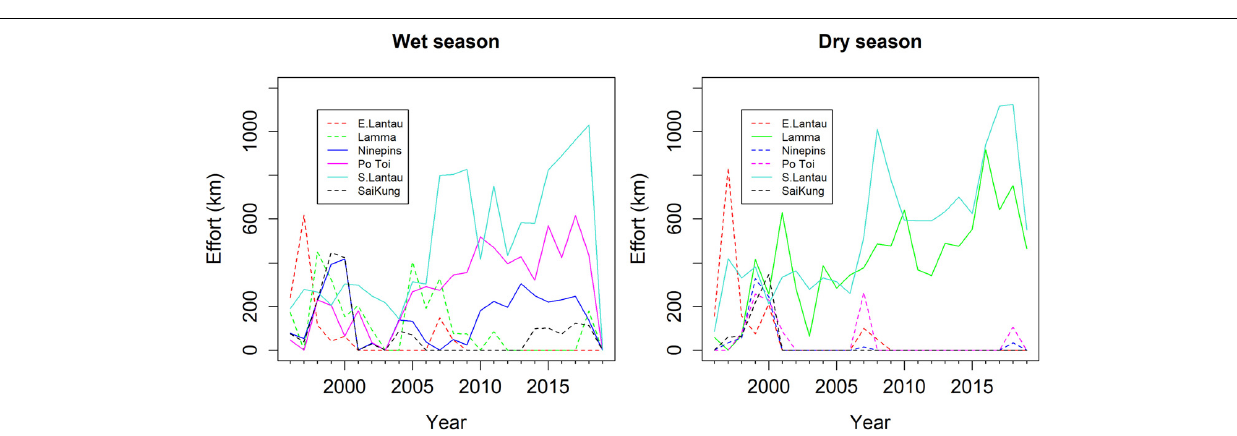
FIGURE 4 | Effort conducted (Beaufort states 0–3) by year and strata. Solid and dotted lines show effort for sites included and excluded from the analysis,